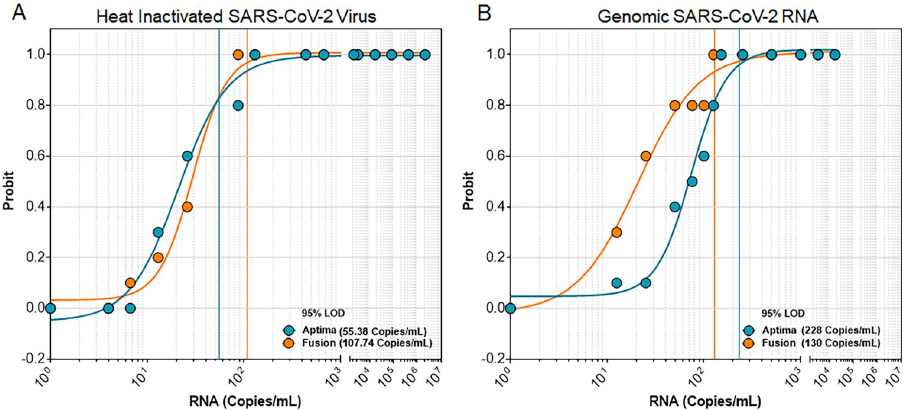
Fig 5. Source of RNA impacts LLOD. LLOD for the Hologic Panther 1 SARS-CoV-2 assays determined by 5 independent measurements, performed over 5 days in duplicates (n = 10 for each datapoint). Blue: Aptima 1 results. Orange: Fusion 1 results. (A) Heat Inactivated Virus target in STM/UTM (B) Genomic RNA target in STM/UTM. The probit (predicted proportion of replicates positive) versus the SARS-CoV-2 RNA concentration identified.